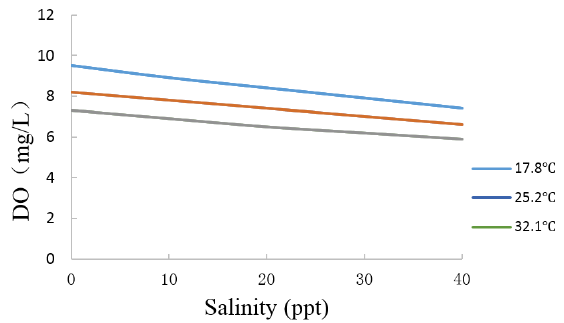
Figure 8. Salinity compensation test.